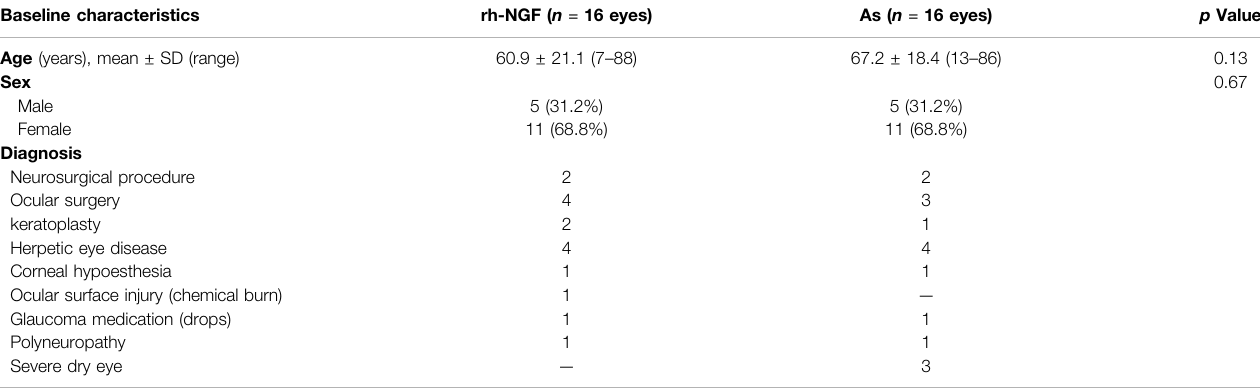
TABLE 2| Participant baselinecharacteristicsdemonstratingthattherewere nosigni fi cantdifferences inpatientdemographicsbetweenthetreatment and historical control groups. Baseline characteristics